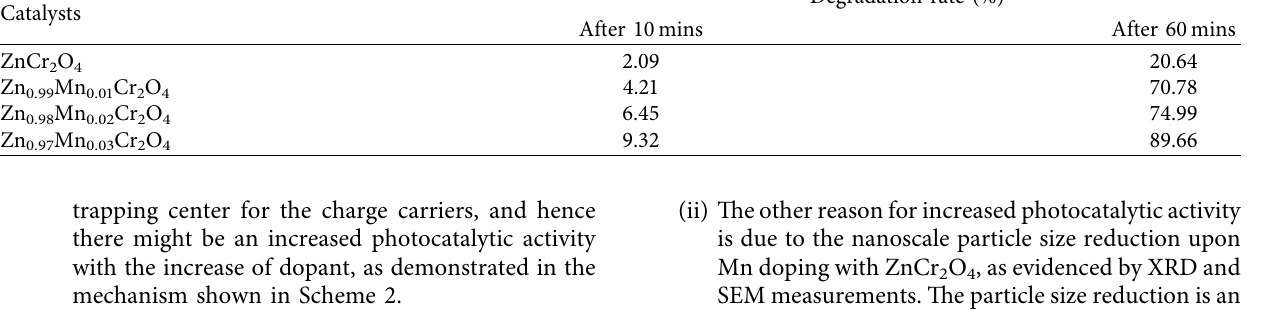
2 O 4 and (b–d) Zn 1 − x Mn x Cr 2 O 4 ( x 2 O 4 -based catalysts with organic pollutants (MB).